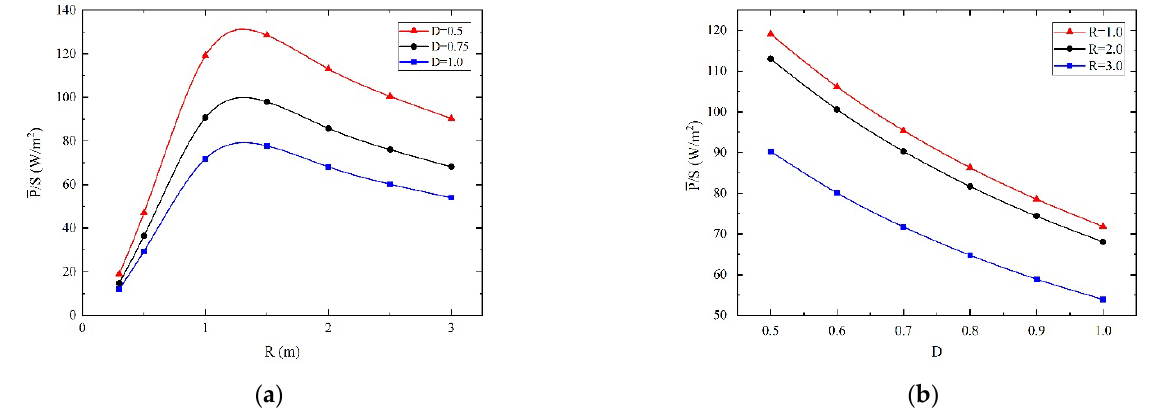
Figure 11. P/S with buoy-shape parameters under optimal C PTO . ( a ) P/S with different R. ( b ) P/S with different D.